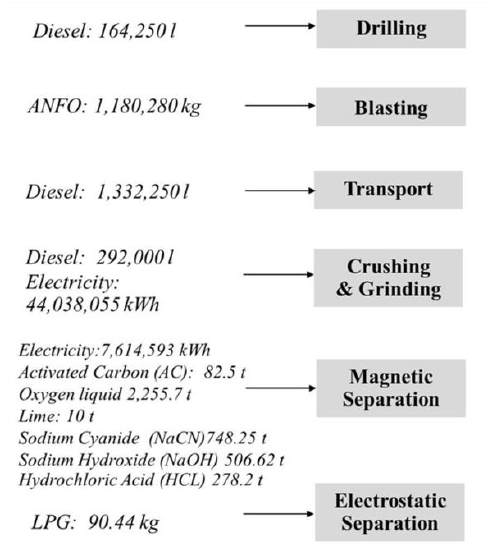
Fig. 5. Potential sources of emissions in each process of the company A